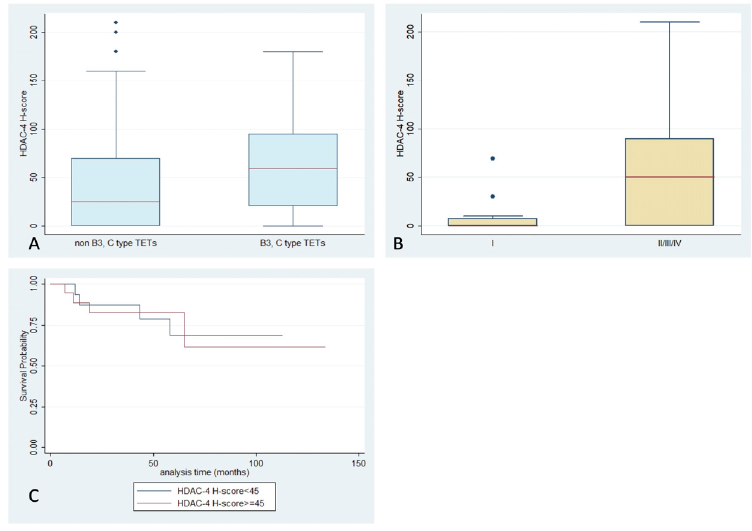
Figure 5. Schematic representation of the associations between HDAC4 H-score and ( A ) WHO histological type, ( B ) Masaoka–Koga stage, and ( C ) patients’ overall survival.